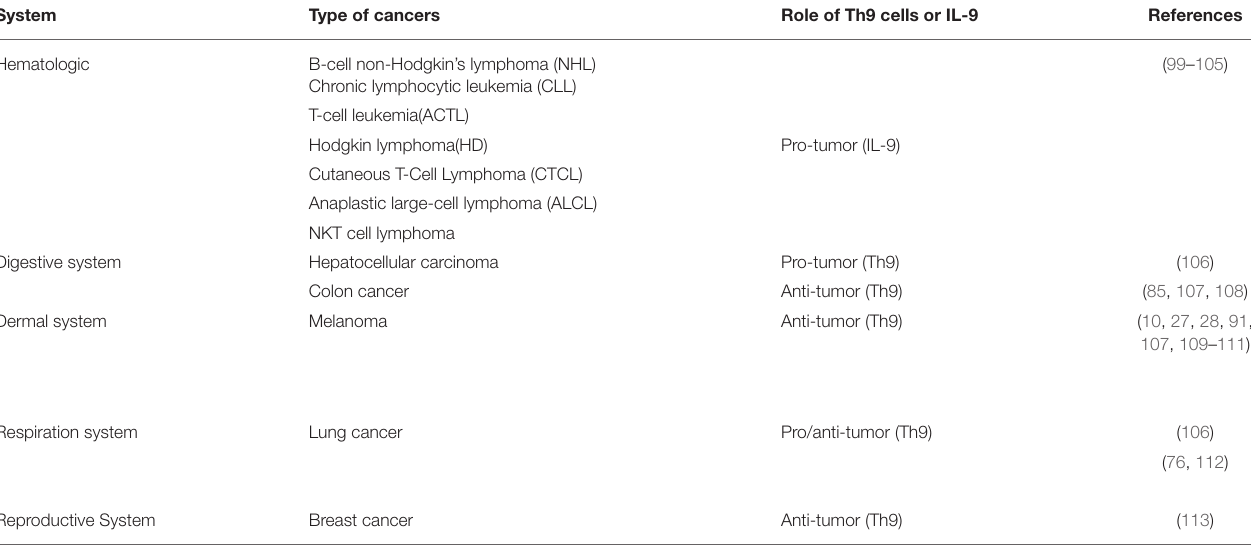
TABLE 2 | Functions of Th9 cells and1 IL-9 on different